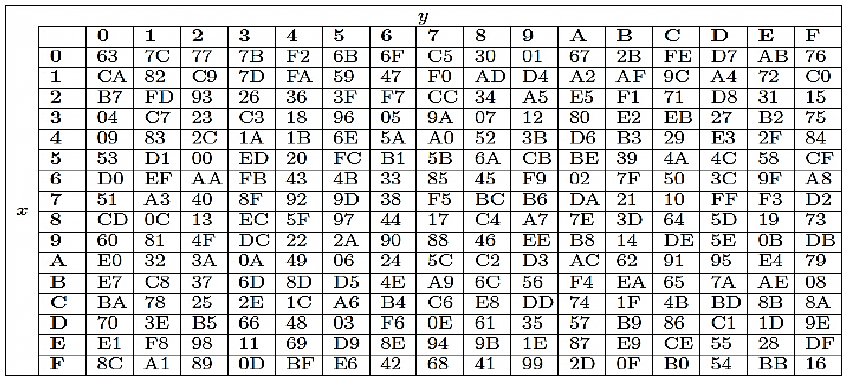
Figure 2. Sbox involved in the Substitute Bytes transformation.